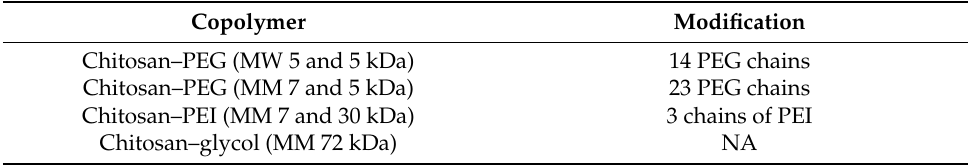
Table 2. Composition of the chitosan copolymers used.